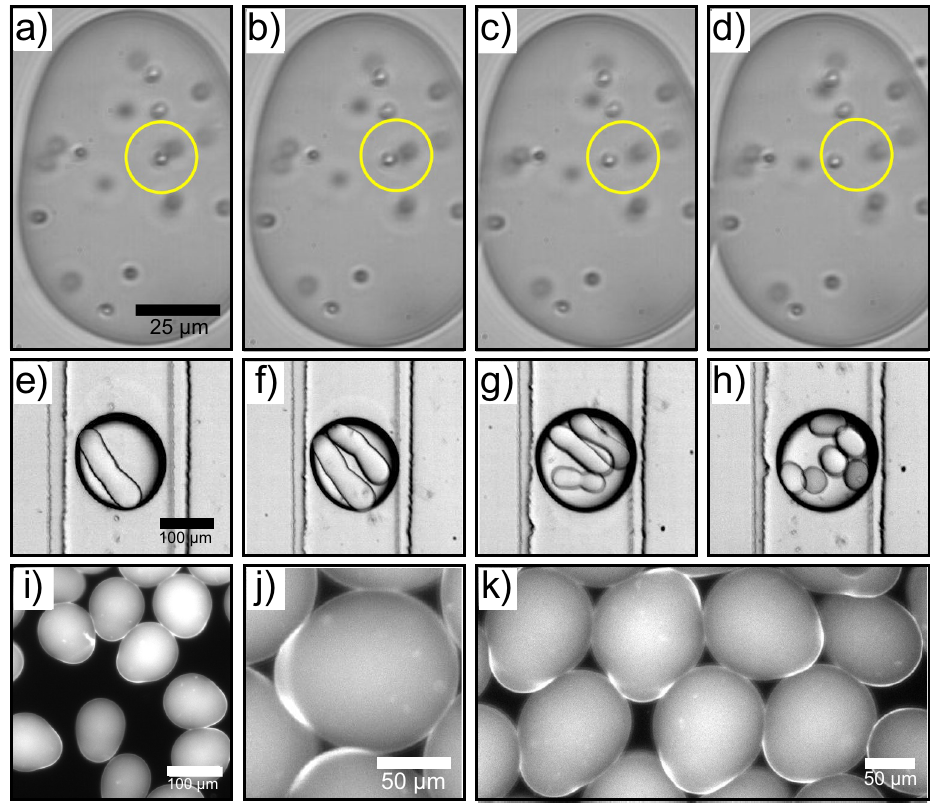
Figure 5. (a–d) Time-lapse microscopy sequence of asymmetric core-shell microgels with colloidal particles encapsulated within them. The yellow circles show an example of a colloidal pair, where the particles move with respect to each other freely within the microgel, indicating that the core is liquid and only the external surface has aggregated/gelled. (e–h) Wow double emulsions with asymmetric tubular microgels as the core part of the hierarchical structure. For ( e – g ), the outer phase flow ranged from 400 − 600 µ L/h respectively while the oil to protein phase flow rate ratio was kept constant at 4:1. For ( h ), the oil to protein phase flow rate ratio was 7:1, while the outer phase flow rate was 400 µ L/h . (i–k) Fluorescence microscopy images of janus-like microgels formed using a microfluidic device with a 60 ◦